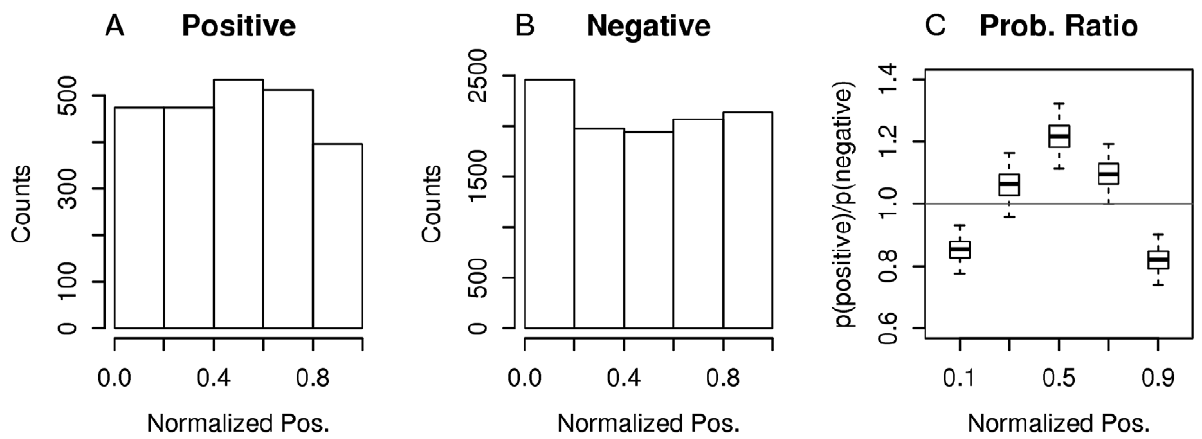
Figure 1. Distributions of normalized positions of MHC-I restricted T-cell epitopes for viruses. (A and B) For each category of peptides indicated (i.e. ‘Positive’ or ‘Negative’), peptides were mapped onto all proteins of the corresponding genome with peptide similarity cutoff of 100%. For each peptide:antigen mapping, a normalized position was calculated. The set of normalized positions was plotted as a histogram. (C) To show positional bias of epitopes, the box plot shows results of 1000 bootstrap sampling of Positive and Negative data sets of normalized positions and plotting ratios of their probabilities for each bin. Boxes cover the range from 25 th to 75 th percentiles. Whiskers extend out from boxes 1.0 times the interquartile range.